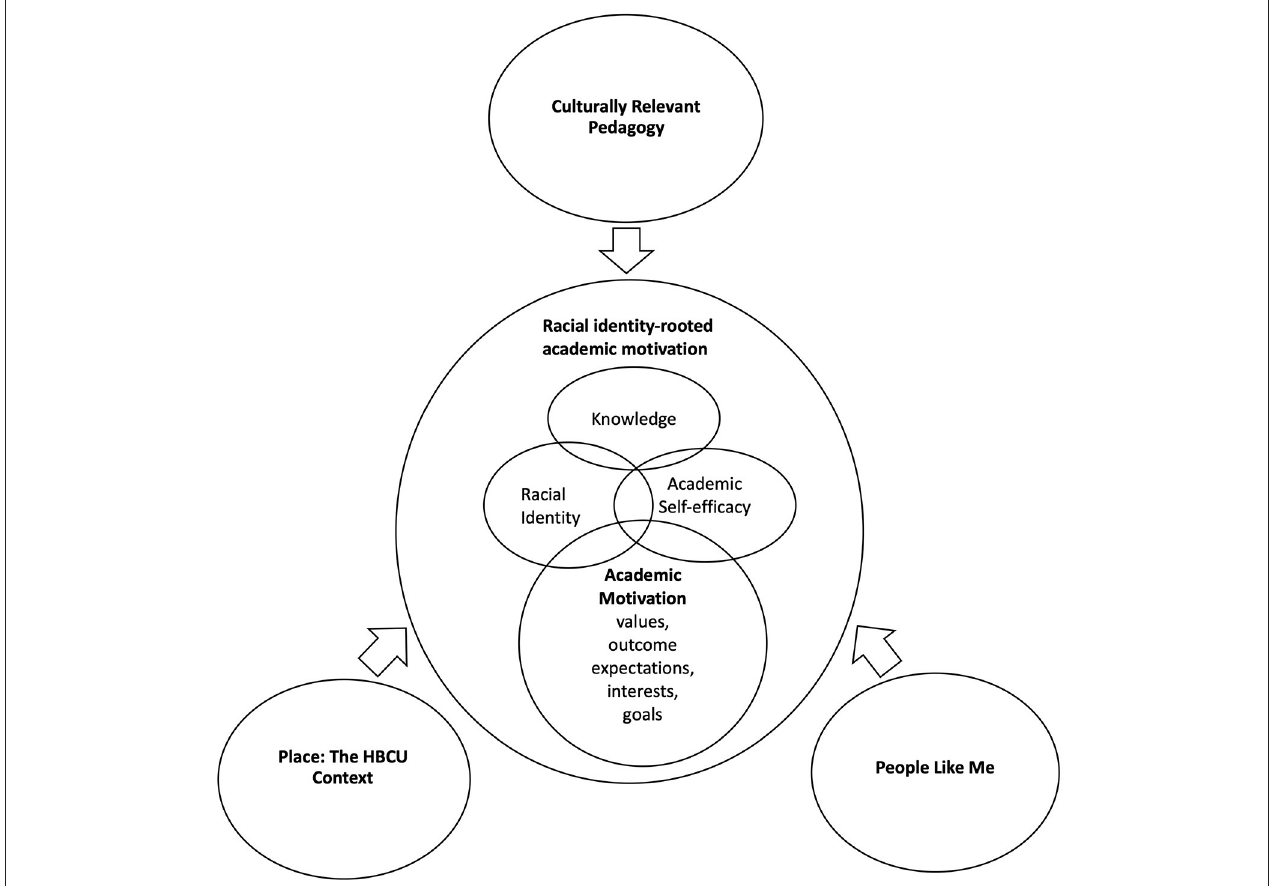
FIGURE 1 | Conceptual framework: The development of racial identity-rooted academic motivation at an